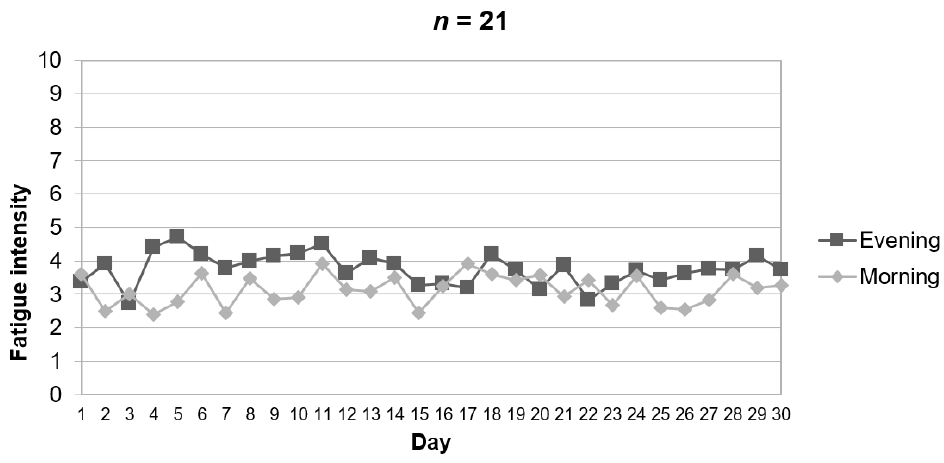
Figure 3. Evolution of fatigue in the morning and evening during the study based on ecological momentary assessment with the app.